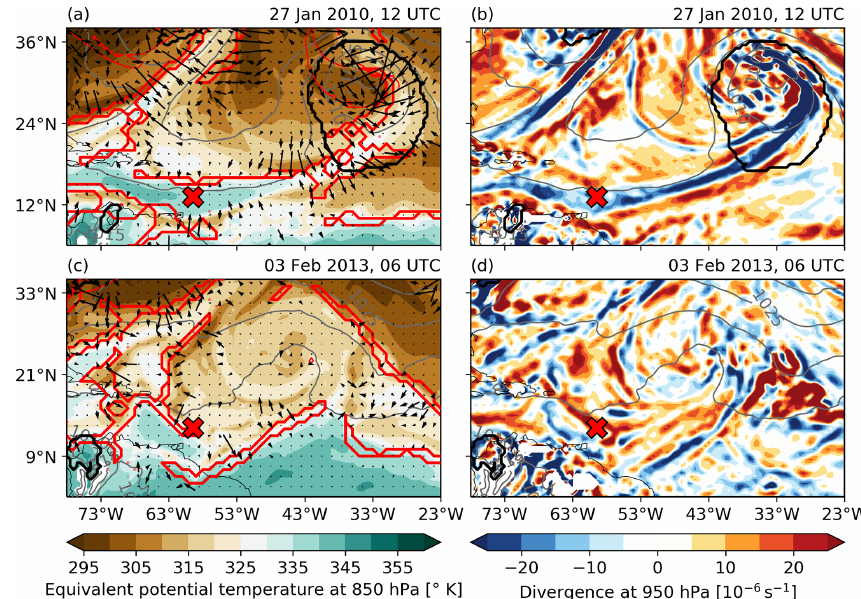
Figure 11. Synoptic situation over the North Atlantic on the EDI day with the strongest (a, b) low-level convergence (27 January 2010) and (c, d) low-level divergence (3 February 2013) in the quasi-climatological period. Shown are (a, c) equivalent potential temperature at 850hPa (shading), with ERA-Interim fronts (thick red contours), Q vectors (calculated with the full horizontal wind at 850hPa previously smoothed with a Gaussian filter), and 2pvu at 320K (thin red contours); and (b, d) horizontal divergence at 950hPa (shading), with sea level pressure (gray; 5hPa intervals), cyclone masks (black), and the location of the BCO (red cross). Data: ERA5.